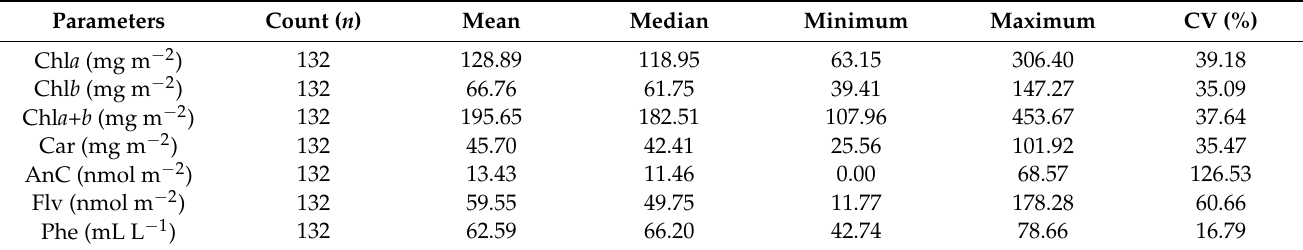
Table 1. Descriptive analysis in lettuce plants. Parameters: Chlorophyll a (Chl a ; mg m −2 ); Chloro-